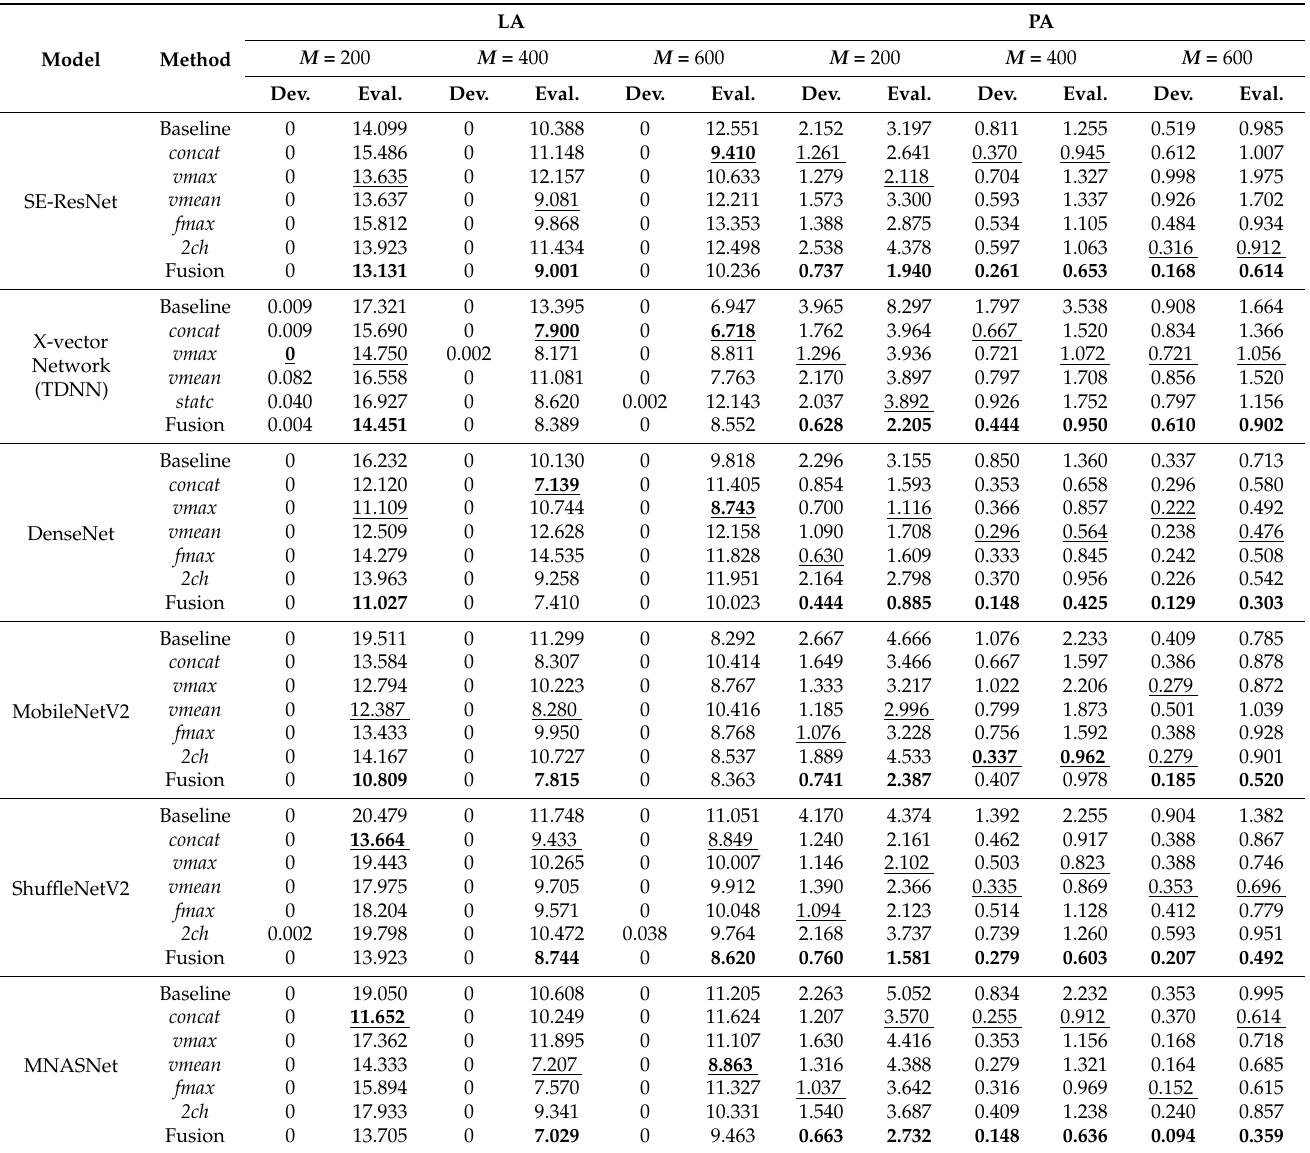
Table 1. EERs (%) of systems on the development and evaluation trials of ASVspoof 2019 LA and PA scenarios. For each model, the lowest EER is highlighted in bold (comparison including Fusion ) or is underlined (comparison excluding Fusion